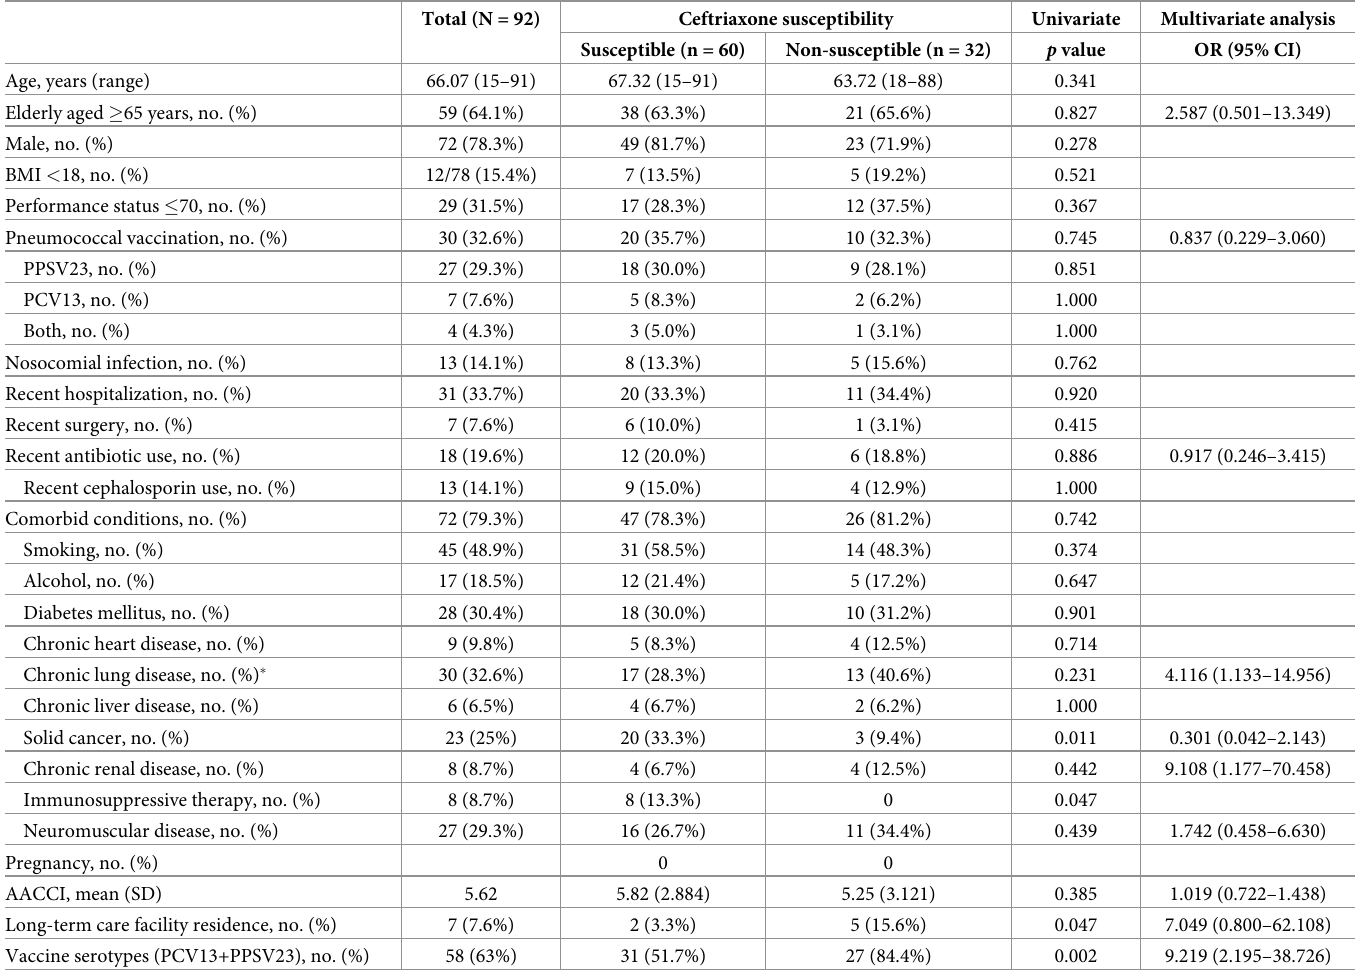
Table 1. Factors associated with ceftriaxone non-susceptible Streptococcus pneumoniae in adult